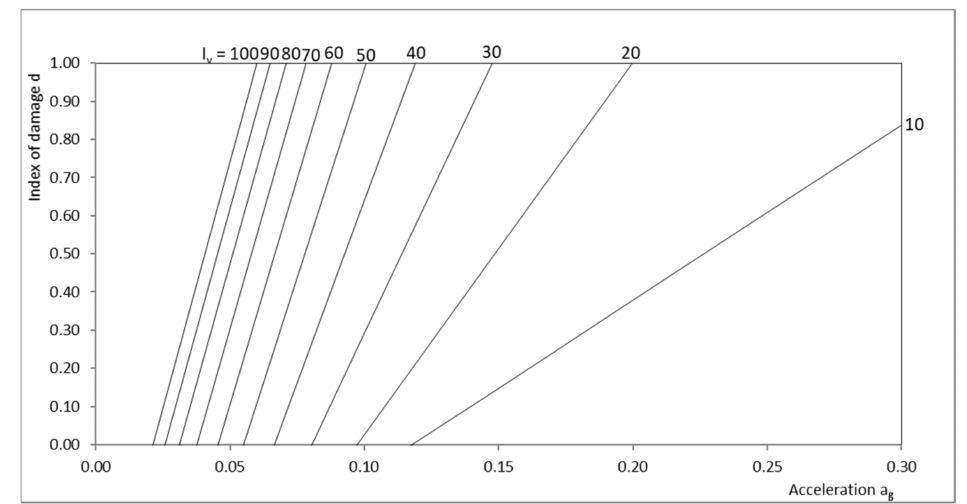
Figure 18. Vulnerability curves for the historic center of Kaštel Kambelovac.